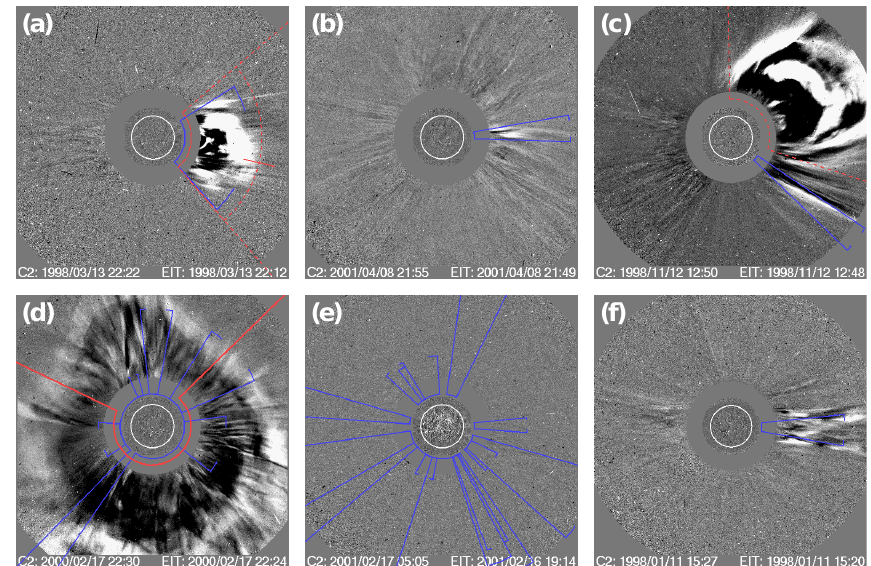
Fig. 1. CMEs in the CDAW (red) and CACTus (blue) catalogs. (a) A CME in both catalogs. The listed properties for the CME are almost the same in the two catalogs. (b) A CME listed in CACTus but not in CDAW. (c–e) False CACTus CMEs. (f) Gusty flows in the aftermath of a large CME. This is a possibly true CACTus CMEs. The monthly movies for sampled period are available at CDAW website (http://cdaw.gsfc.nasa.gov/publications/soho20movie/). the event is true or false, thus we refer to them as possibly true